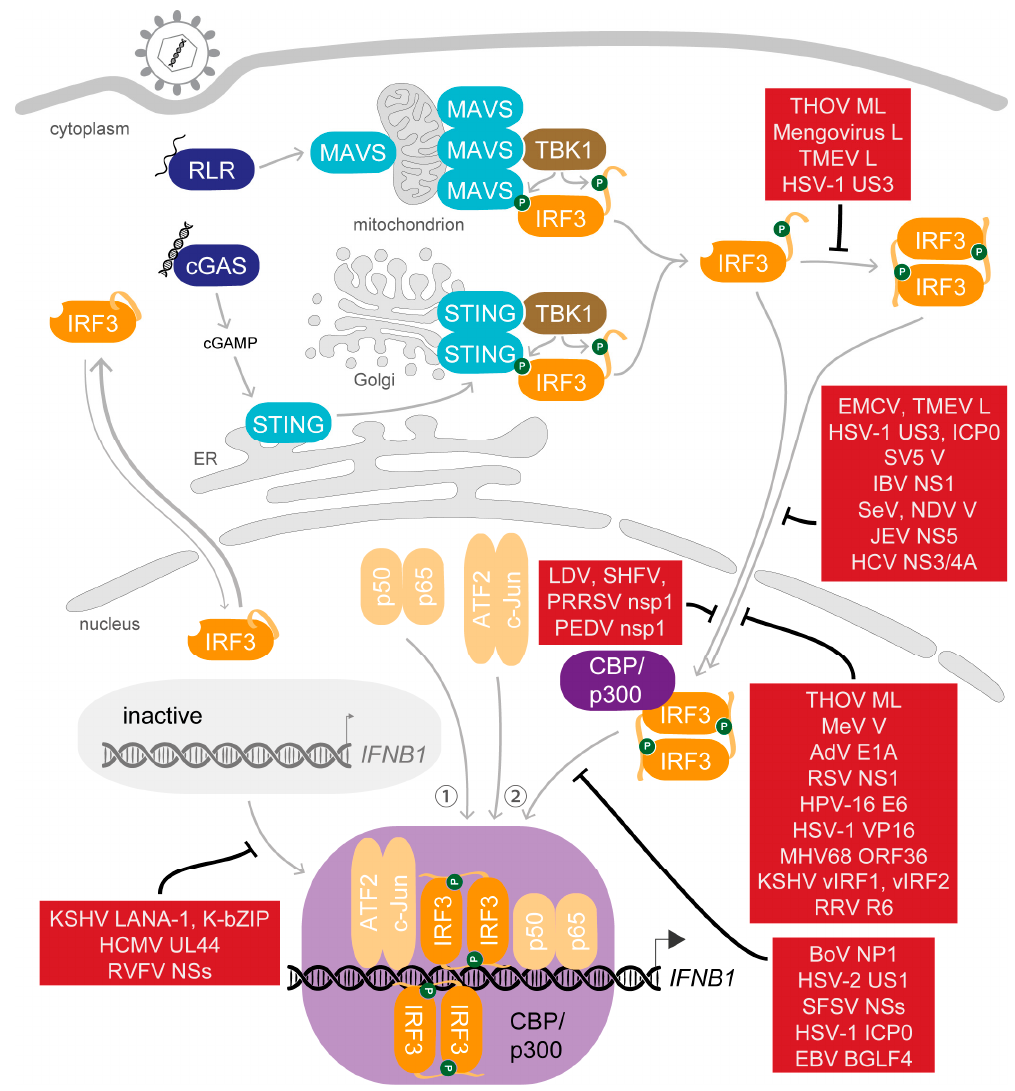
Figure 4. Viral antagonists of phosphorylated IRF3. Viral inhibitors of IRF3-dependent IFNB1 expression are listed in red boxes, with blind-ended lines indicating the step of intervention. Not shown are viral factors targeting the initial phosphorylation step and factors mediating IRF3 degradation.